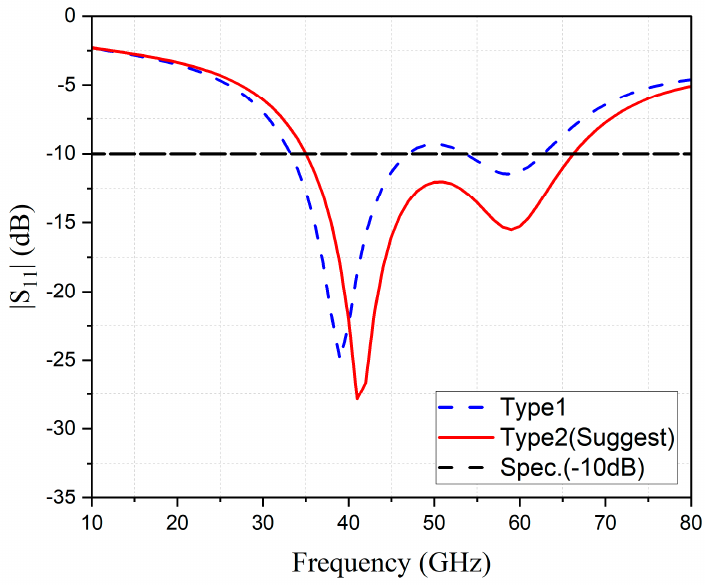
Figure 16. Simulation diagram with and without AMC .